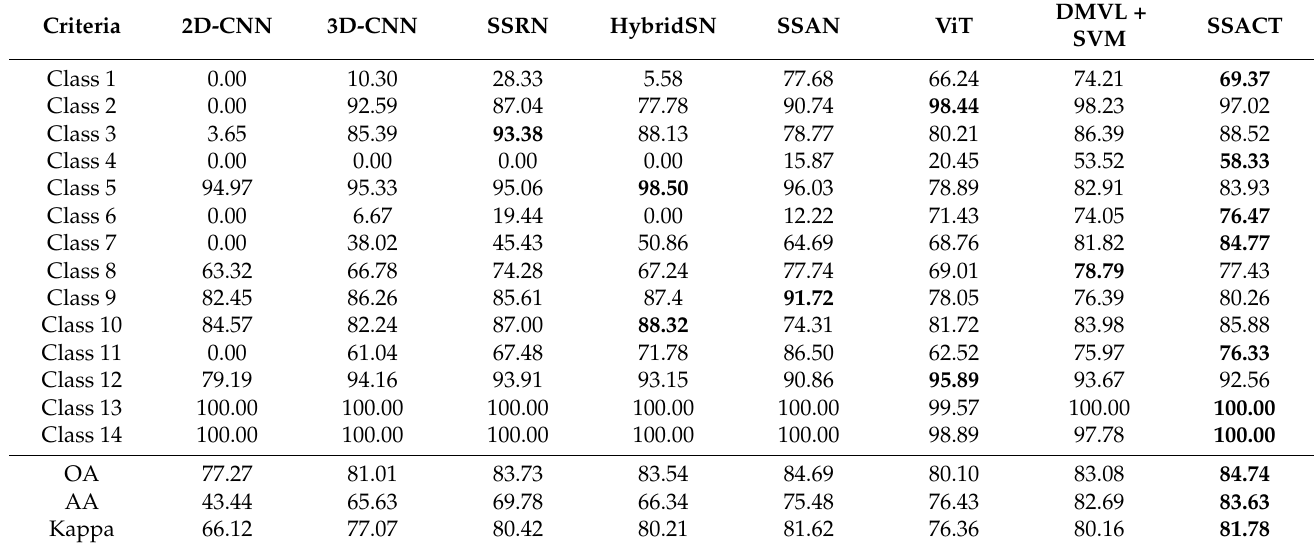
Table 3. Classification results (%) by selecting 10% labeled samples of the HL dataset.